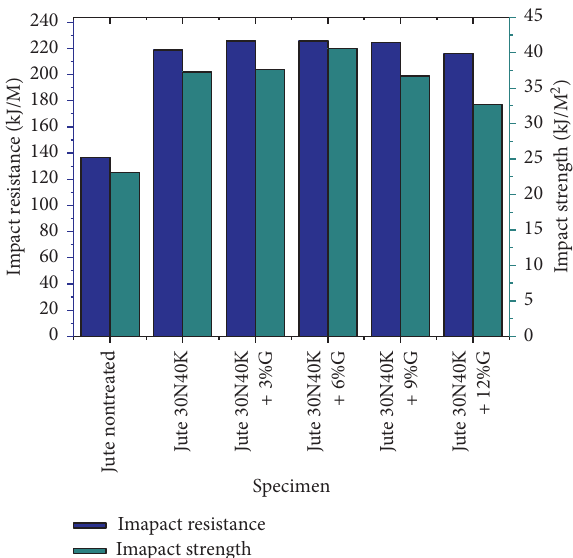
Figure 7: Impact strength of UJE polymer